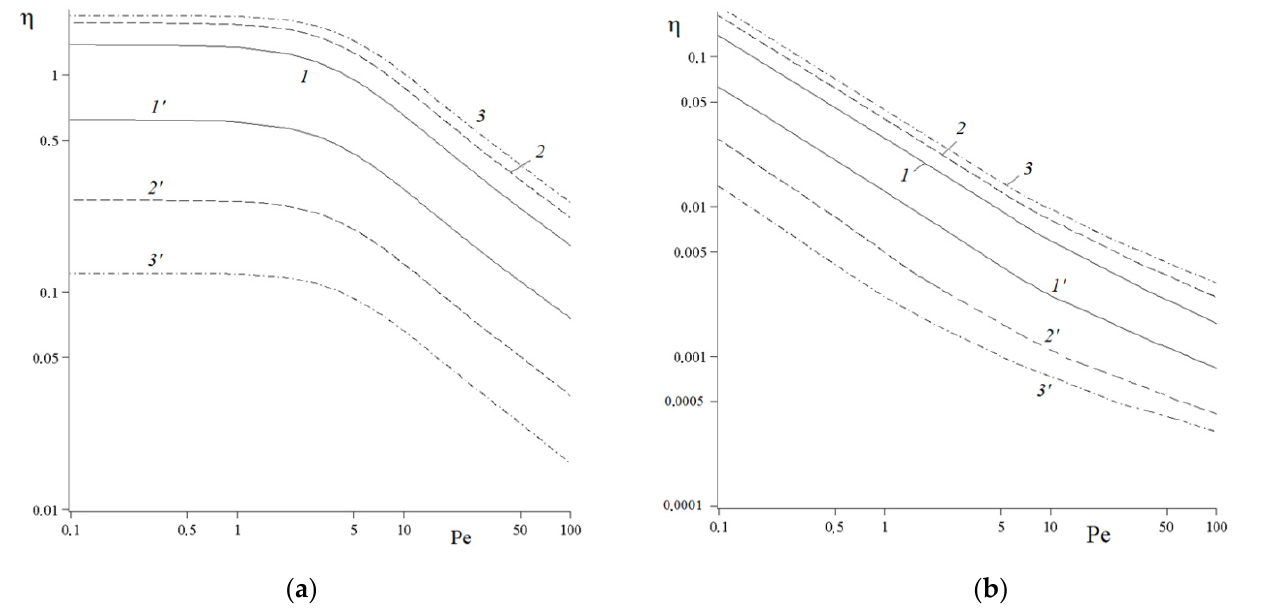
Figure 4. Retention efficiencies for fibers with profiling (with protrusions of rectangular cross section) vs. Peclet number Pe = ReSc at Sc = 1 ( a ), 1000 ( b ): (curves 1–3 )—deposition on external protrusions, ( 1 ’– 3 ’)—deposition on the part of the fiber surface of radius a . Calculations for different protrusion heights 0.1 ( 1 , 1 ’), 0.2 ( 2 , 2 ’), 0.3 ( 3 , 3 ’).